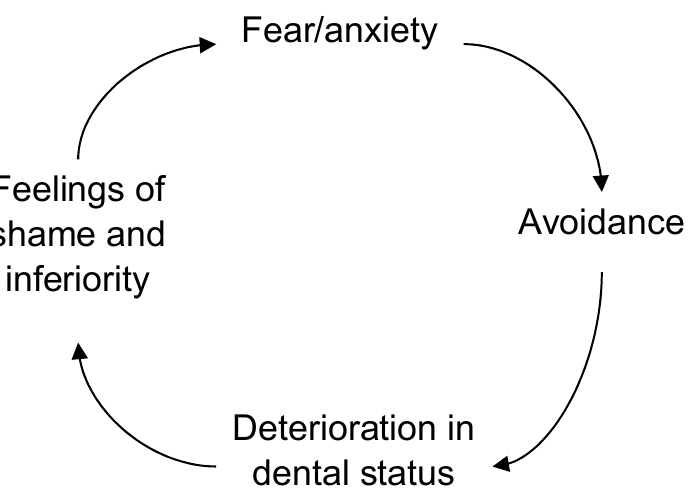
Figure 2. Aetiological model of dental anxiety [5]. Figure 3. The vicious cycle of dental anxiety maintaining and enforcing dental anxiety [2].